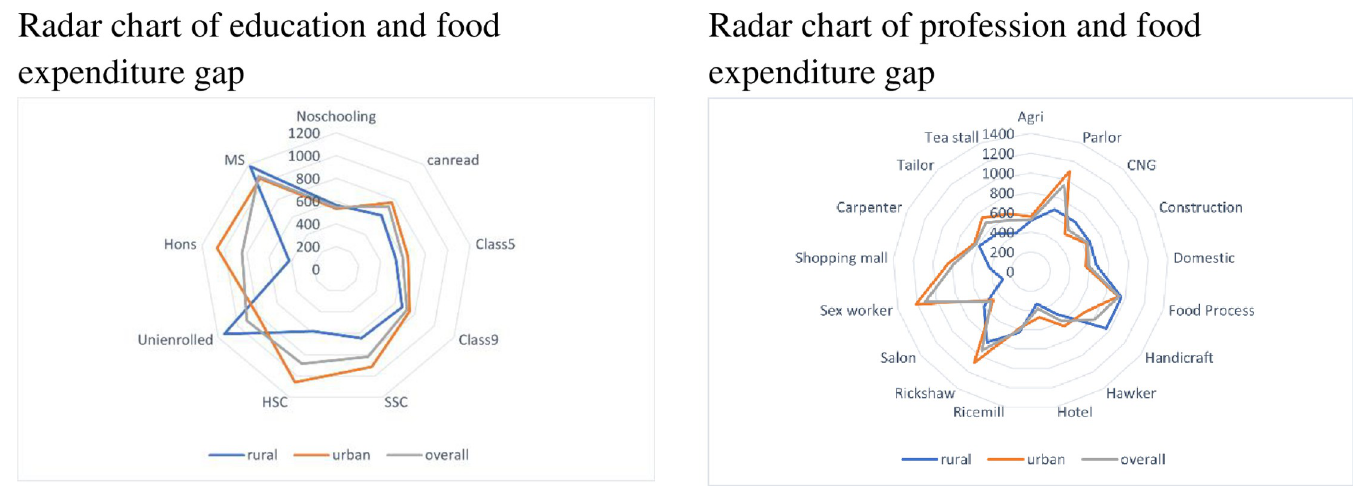
Fig 4. Radar charts of education and profession with the food expenditure gap.